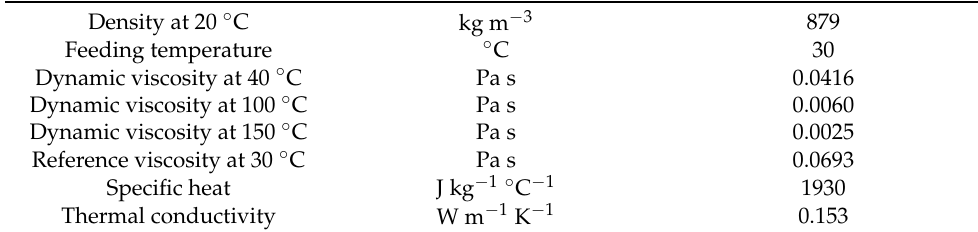
Table 2. Lubricant